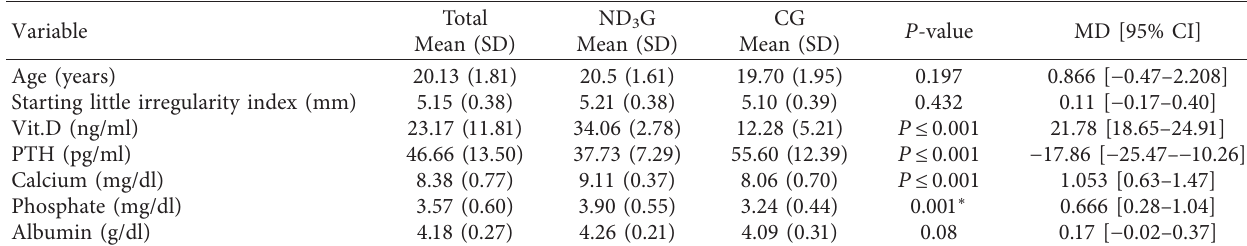
Figure 2: CONSORT diagram showing the flow of subjects through the trial. Table 1: Demographic characteristic of